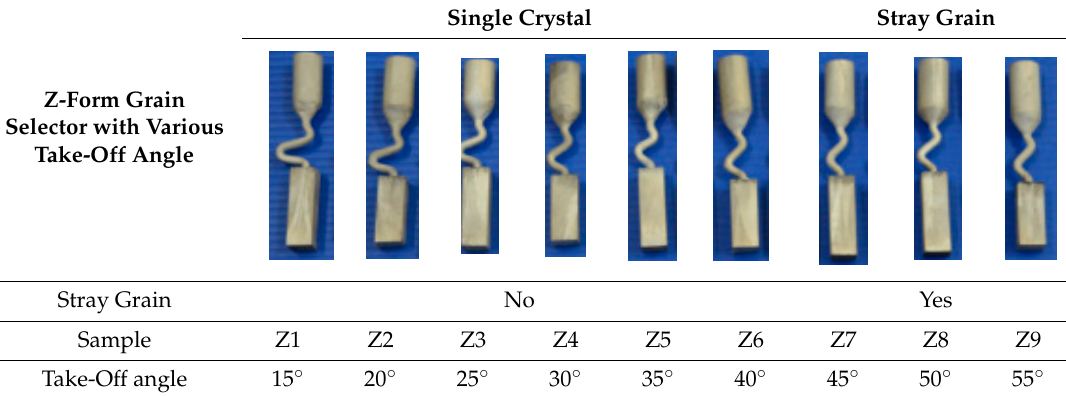
Table 2. Variation in take-off angle of the grain selector portion.